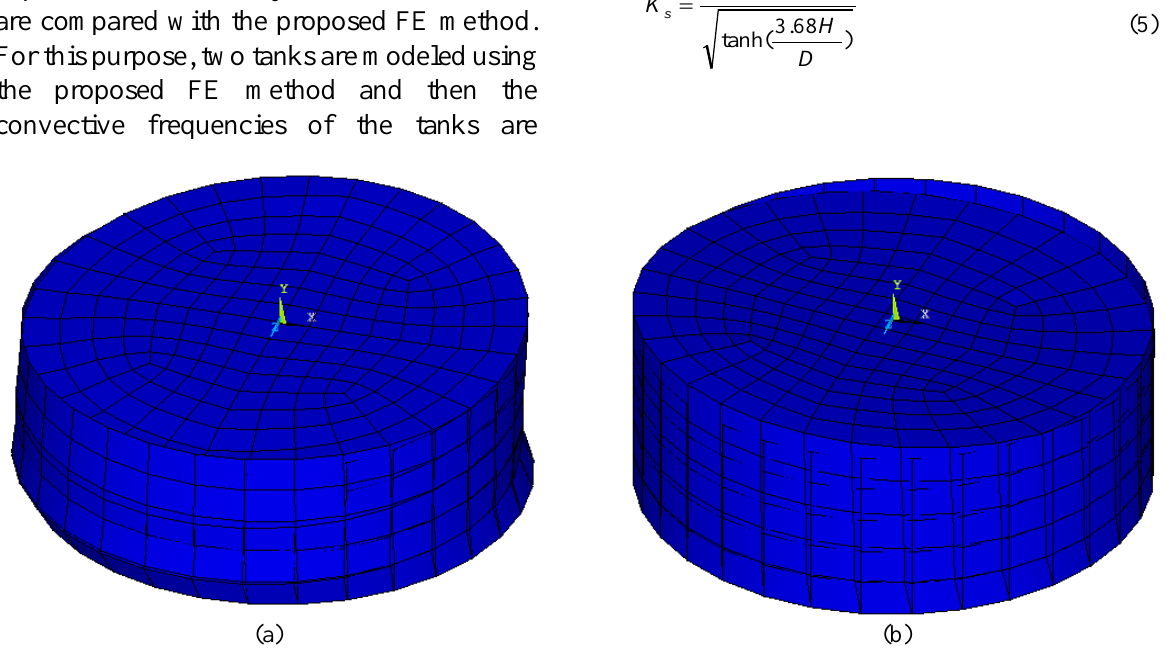
Fig. 3. Fundamental mode shapes of tanks; a) impulsive; b) convective Table 1. Comparisons fundamental frequencies calculated with the present study and with Barton and Parker (1987) Type of Study